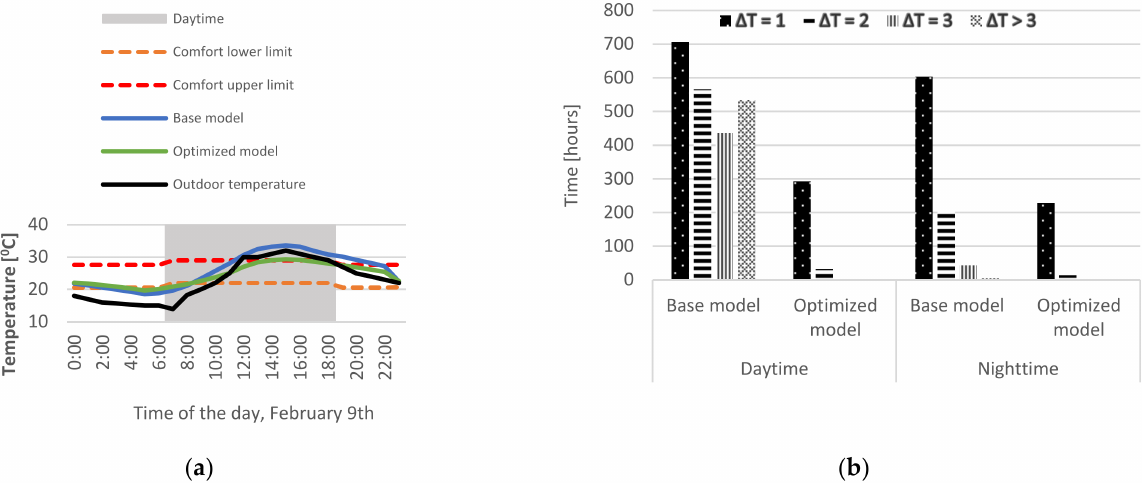
Figure 9. ( a ) The outdoor temperature on a typical day with large diurnal variation and the in- door temperature in the base model and optimized model; ( b ) The annual number of hours when the operative temperature was outside the adaptive comfort zone by temperature difference from comfort